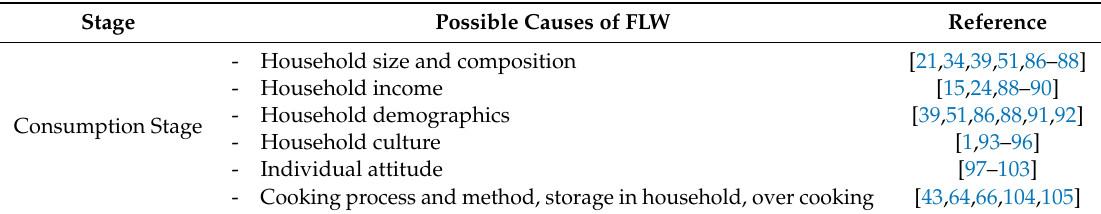
Table 10. Possible causes of FLW at the consumption stage of